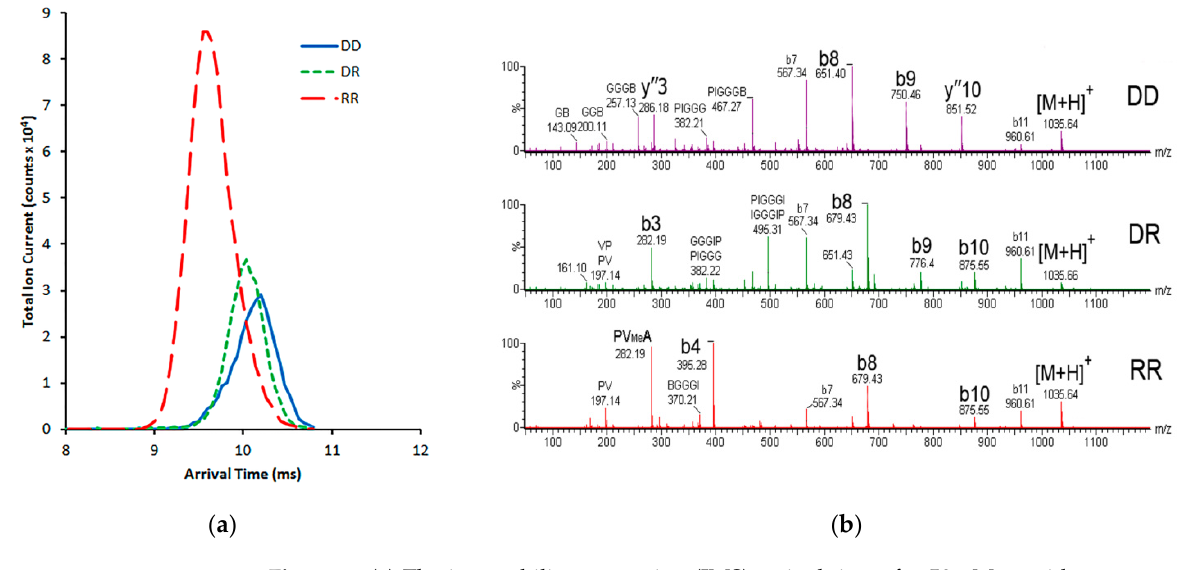
Figure 2. ( a ) The ion-mobility separation (IMS) arrival times for 50 μ M peptides were measured separately. The IMS gas flow was 90 mL/min, the IMS wave velocity was 650 m/s. ( b ) The tandem mass spectra (MS/MS) of the sequence-isomeric peptides.